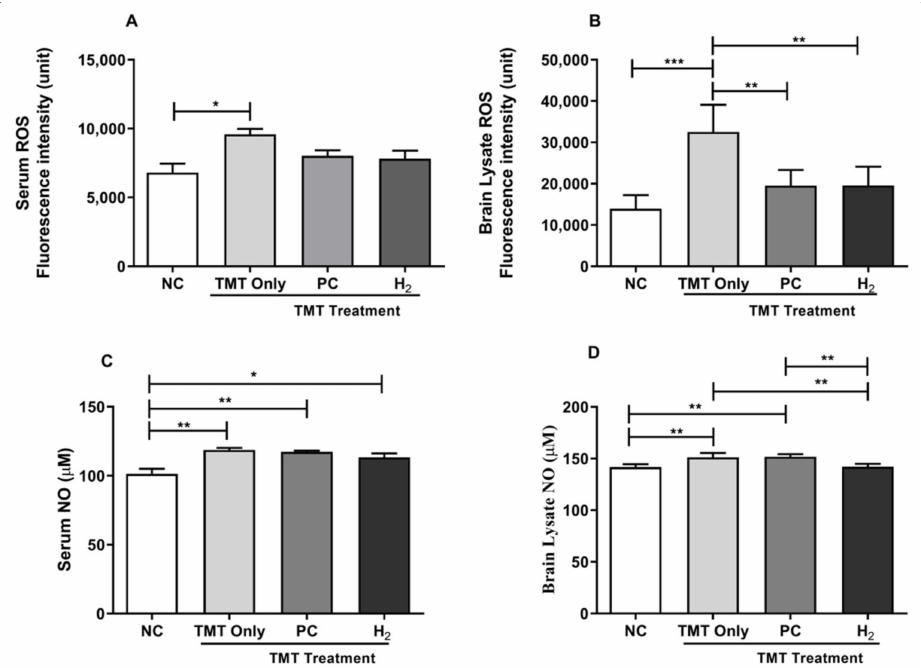
Figure 4. Effects of H 2 gas inhalation treatment on total ROS and NO levels in TMT-induced C57BL/6 mice after four weeks. ( A ) Serum ROS, ( B ) Brain lysates ROS, ( C ) Serum NO, and ( D ) Brain lysates NO levels. Data are shown as the mean ± SEM for n = 4 mice. Significant differences were analyzed with ANOVA and Tukey’s test. * p < 0.05, ** p < 0.01, *** p <